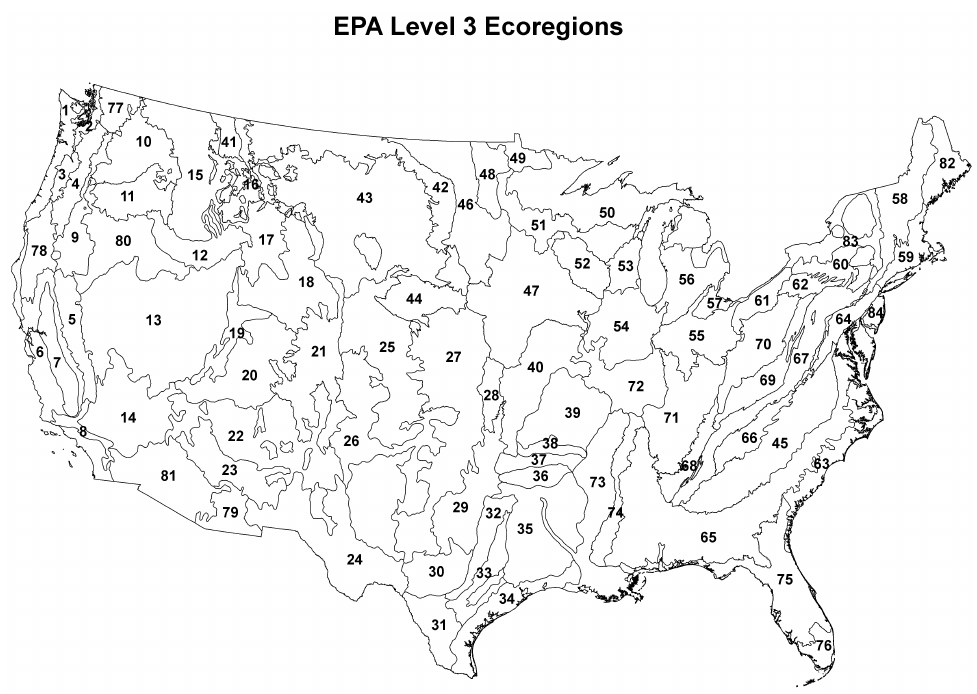
Figure 1. The numbers of the individual Level III EPA ecoregions (1999). Specific ecoregion numbers are called out in the text.